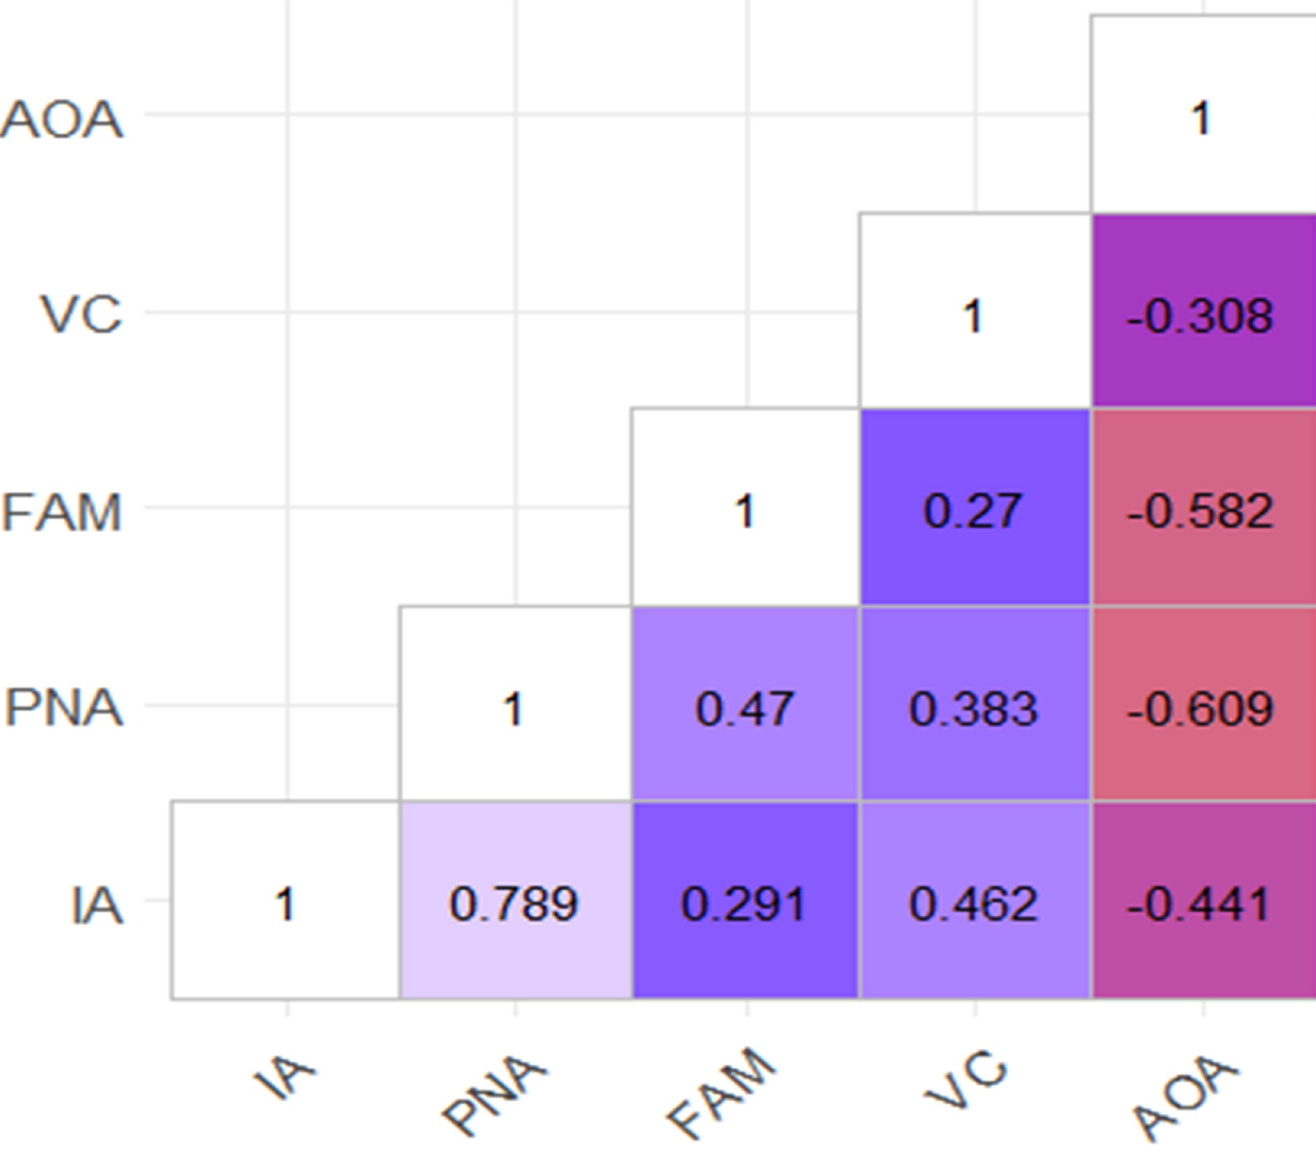
multiplied into 100 (see Table 4 for summary statistics). Reaction time measures for four items ( Barn , Football , Lobster , and Sweater ) were removed from the confrontation naming latency as these items had zero correct responses, accounting for 2.2% of the 180 items RT. The H stats scores for the 180 items demonstrated a range of name agreement from com- plete to very low name agreement across items. Forty-two items (24%) had H stats of zero, meaning they had complete name agreement. Twenty of the 180 items had H stats score above 1.5 indicating very low name agreement ( arrow , barrel , bed , bird , boot , broom , cat , clothes pin , dress , iron , knife , owl , pear , socks , stove , umbrella , vase , wagon , watering can , zebra ) with multi- ple alternative naming responses. The remaining 118/180 items represent H stats score below 1.5 suggesting more than one name was being used by participants to represent these items.